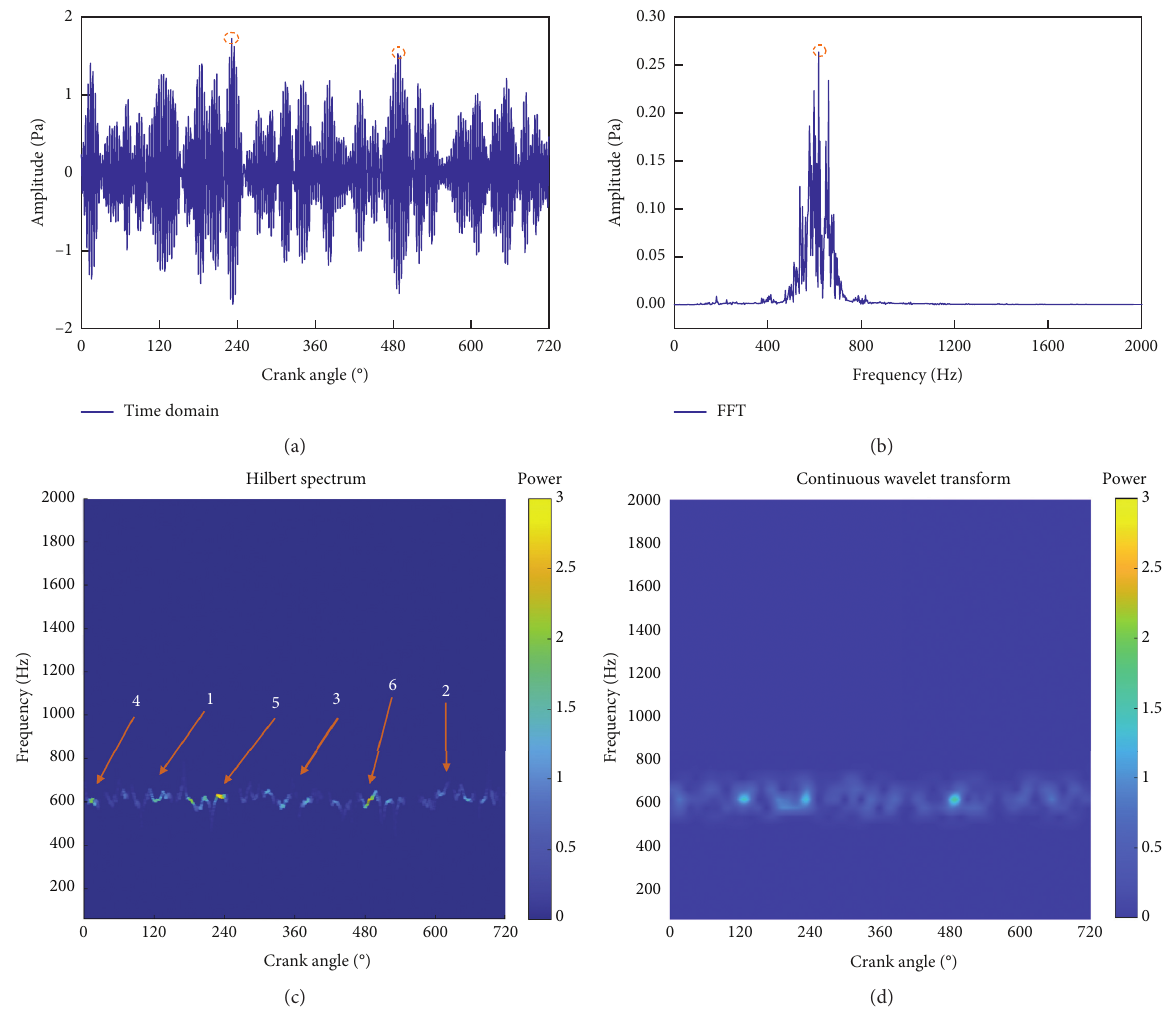
Figure 18: The results of the IC2 component separated by the VMD-FastICA method. (a) Time-domain waveform of IC2. (b) Fourier spectrum of IC2. (c) Hilbert spectrum of IC2. (d) Continuous wavelet transform of